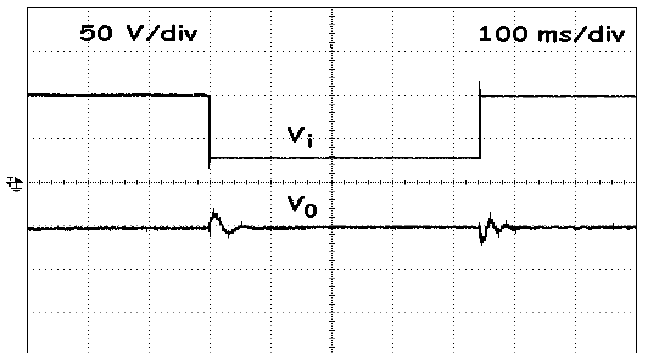
Figure 24. Experimental results for the input and output voltage in transient mode.